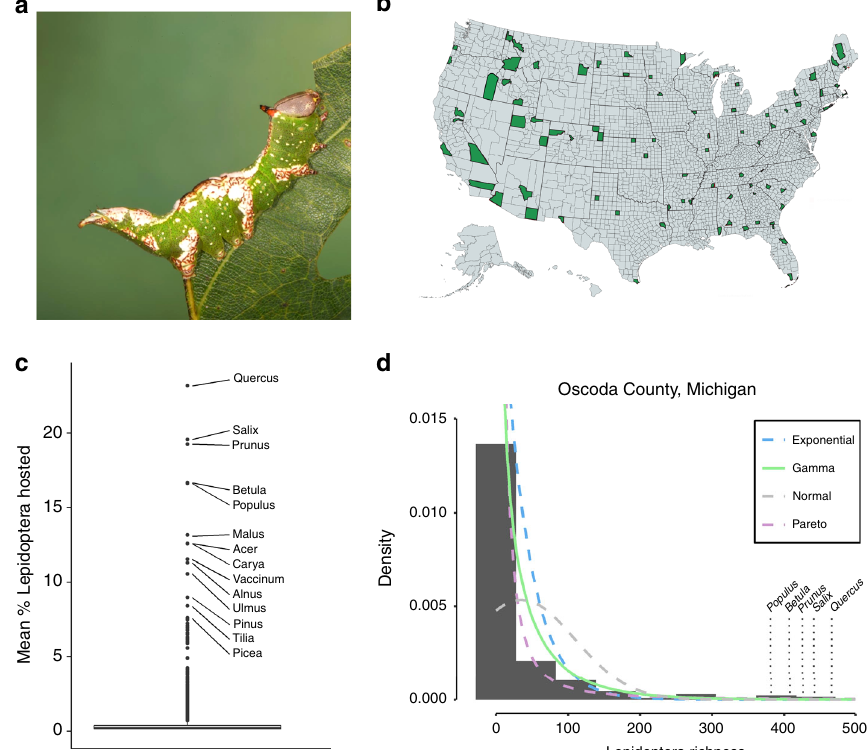
Fig. 1 Across the United States, distributions of Host Plant-Lepidoptera interactions are skewed such that few plant genera support the majority of Lepidoptera species. a White-blotched Heterocampa ( Heterocampa umbrata ) a Lepidopteran from the family Notodontidae. The majority of Lepidopteran caterpillars are constrained to feed on just a few plant genera or families from the total plant diversity available in the landscape (Photo by D. Tallamy); b The 83 United States counties (in green) used in the analyses (map made by KJS using mapchart.net); c Mean % Lepidoptera species hosted by each plant genus across all counties analyzed ( n = 83). The top 15 genera that supported the most Lepidoptera species are labeled. The average percent Lepidoptera species across all plant genera was 0.36% ± 1.41% (range: 0 – 23%). The box plot shows the median (center line), fi rst and third quartile (upper and lower hinges) and 1.5 * interquartile range (whiskers). Data from n = 1997 native plant genera. d Example histogram of Lepidoptera richness by plant genus with four candidate distributions for the 341 woody and herbaceous plant genera in Oscoda County, Michigan. Most (93%) of the 83 counties included in the dataset had distributions that were best fi t by a gamma distribution (solid green line), such that a few plant genera supported high numbers of Lepidoptera species and many plant genera supported few to no Lepidoptera species.